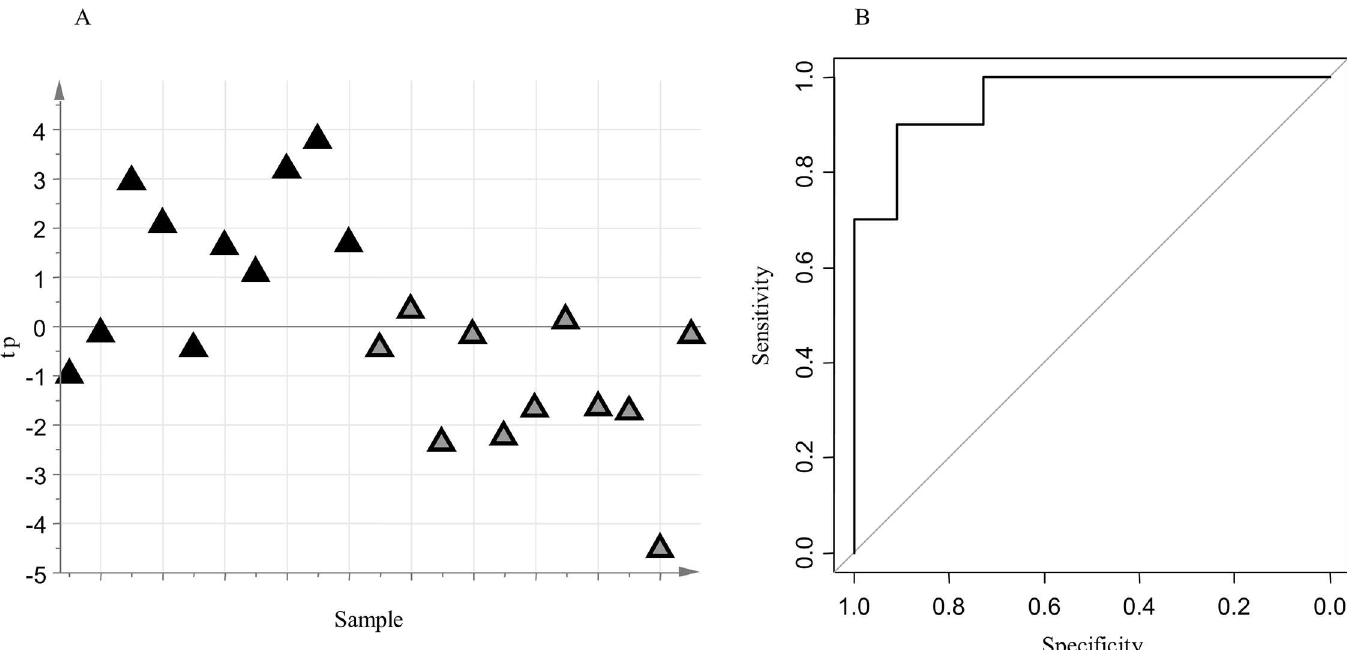
Fig 3. oCPLS2-DA model for PTD with BPD versus PTD without BPD (negative data set); A: score scatter plot of the model (PTD with BPD are reported as black triangles, PTD without BPD as grey triangles); B: ROC curve of the model, calculated by 7-folds full